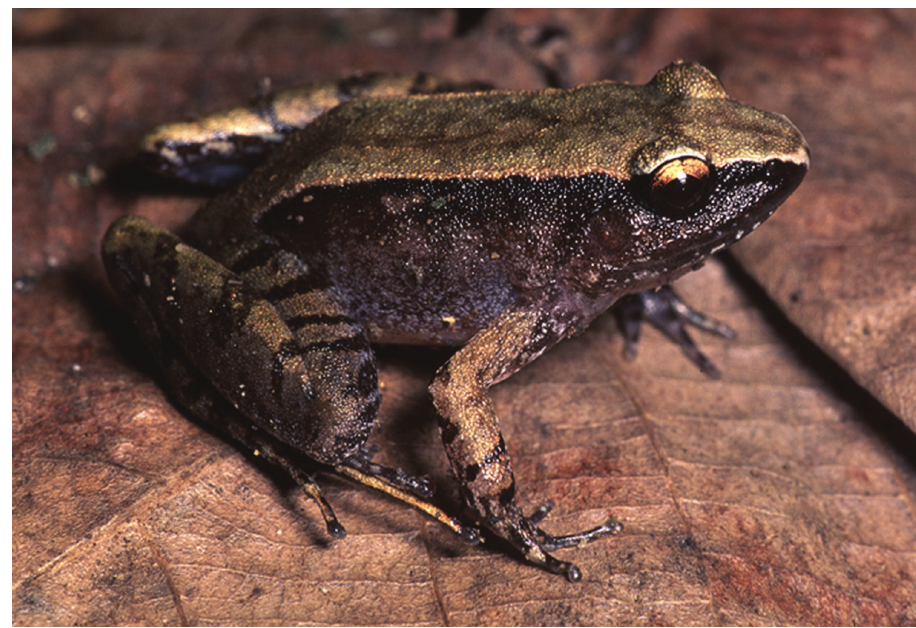
Figure 16. Limnonectes parvus has been collected in Municipality of Bunawan, Agusan del Sur Province. (from Davao City Province; KU 326069). Photo: RMB.